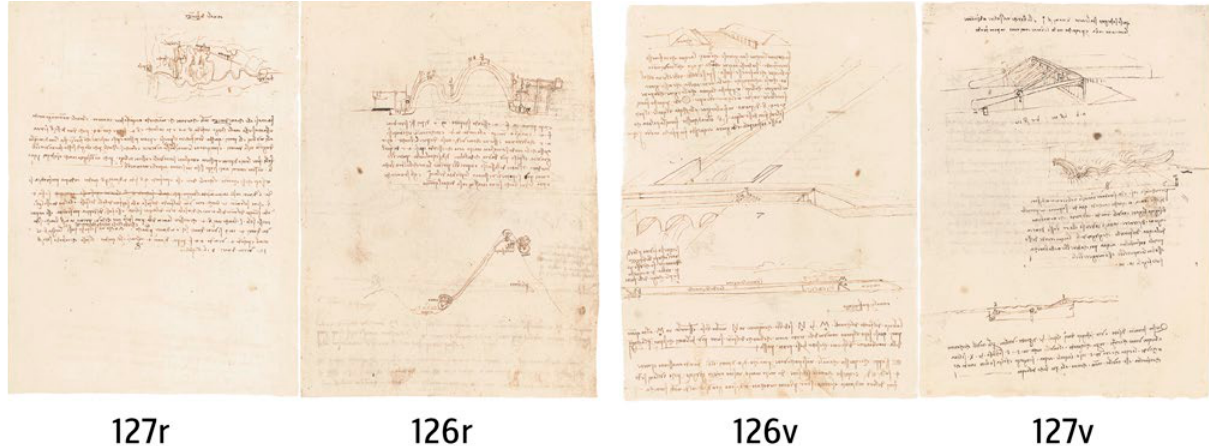
Figure 1. Recomposition of sheets 126r-v and 127r-v of the Codex Atlanticus